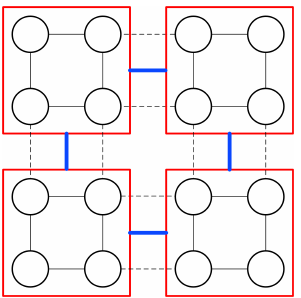
Figure 4: Grouping a set of 4 × 4 nodes into a set of 2 × 2 nodes and implications on the edge